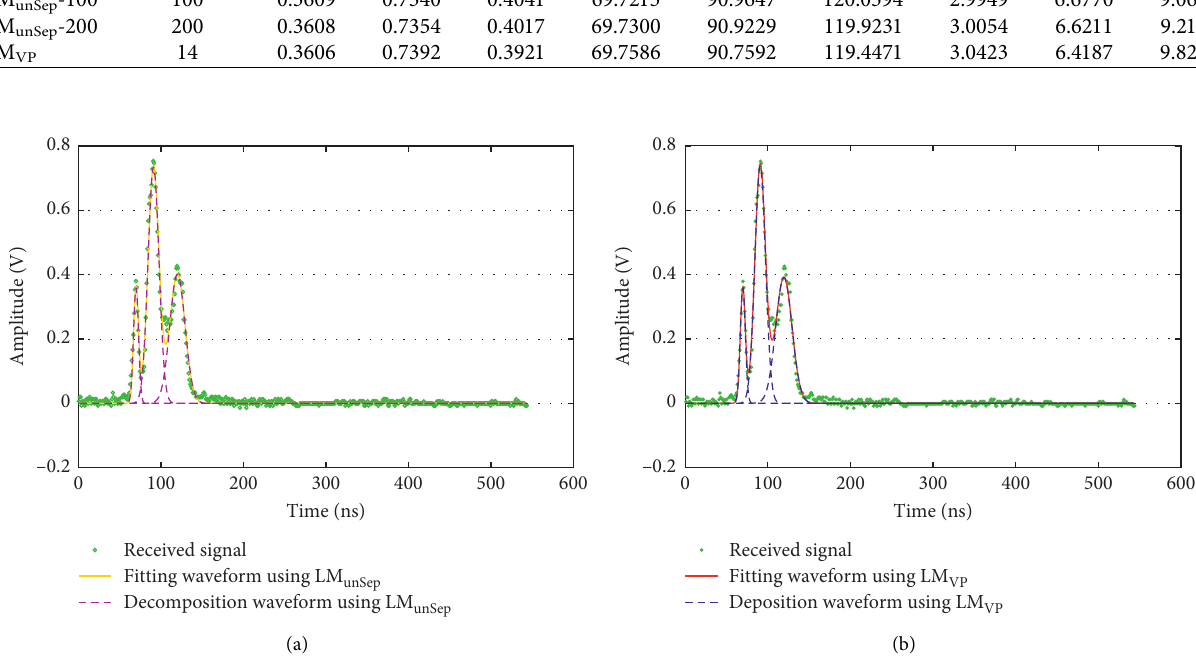
Figure 4: Decomposed waveforms obtained by the (a) LM unSep method and the (b) LM VP method for real data. Table 5: Comparison of effect evaluation coefficients obtained via the two methods in the real